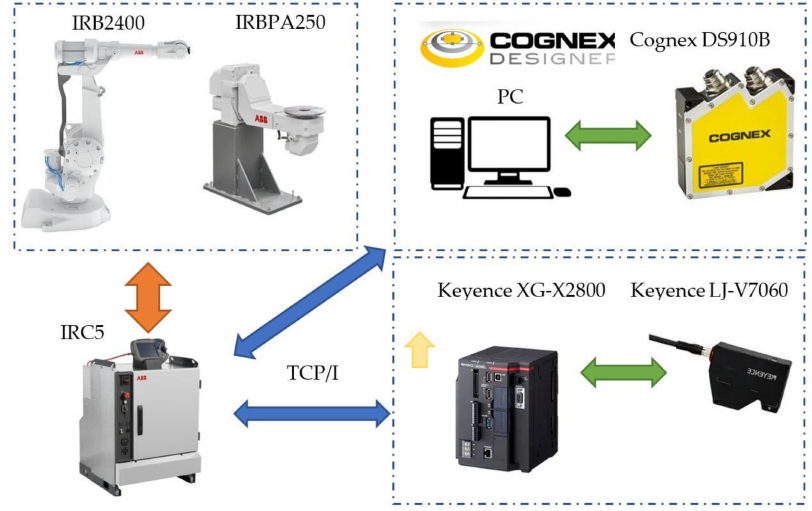
Figure 6. Data communication between the robot’s controller and the Cognex software.